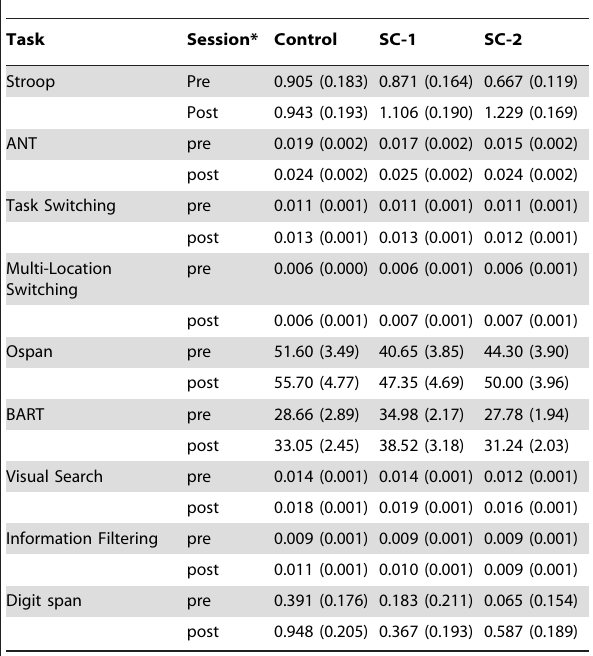
Table 2. The means with standard error in parentheses for pre- and post-test dependent measures (used to calculate meta-analytic Bayes factors) for SC and control (Sims)